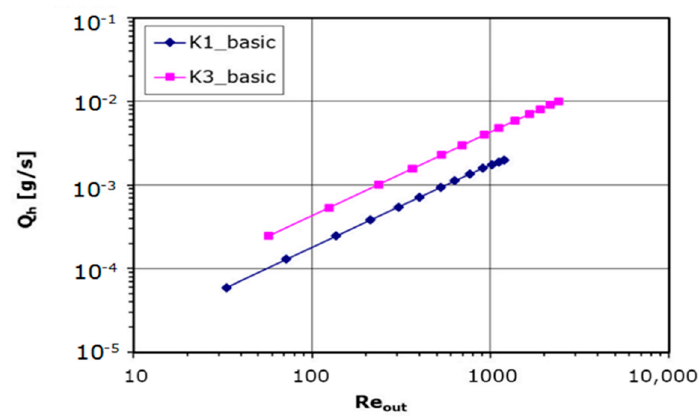
Figure 6. Mass flow rate versus Reynolds number plot.